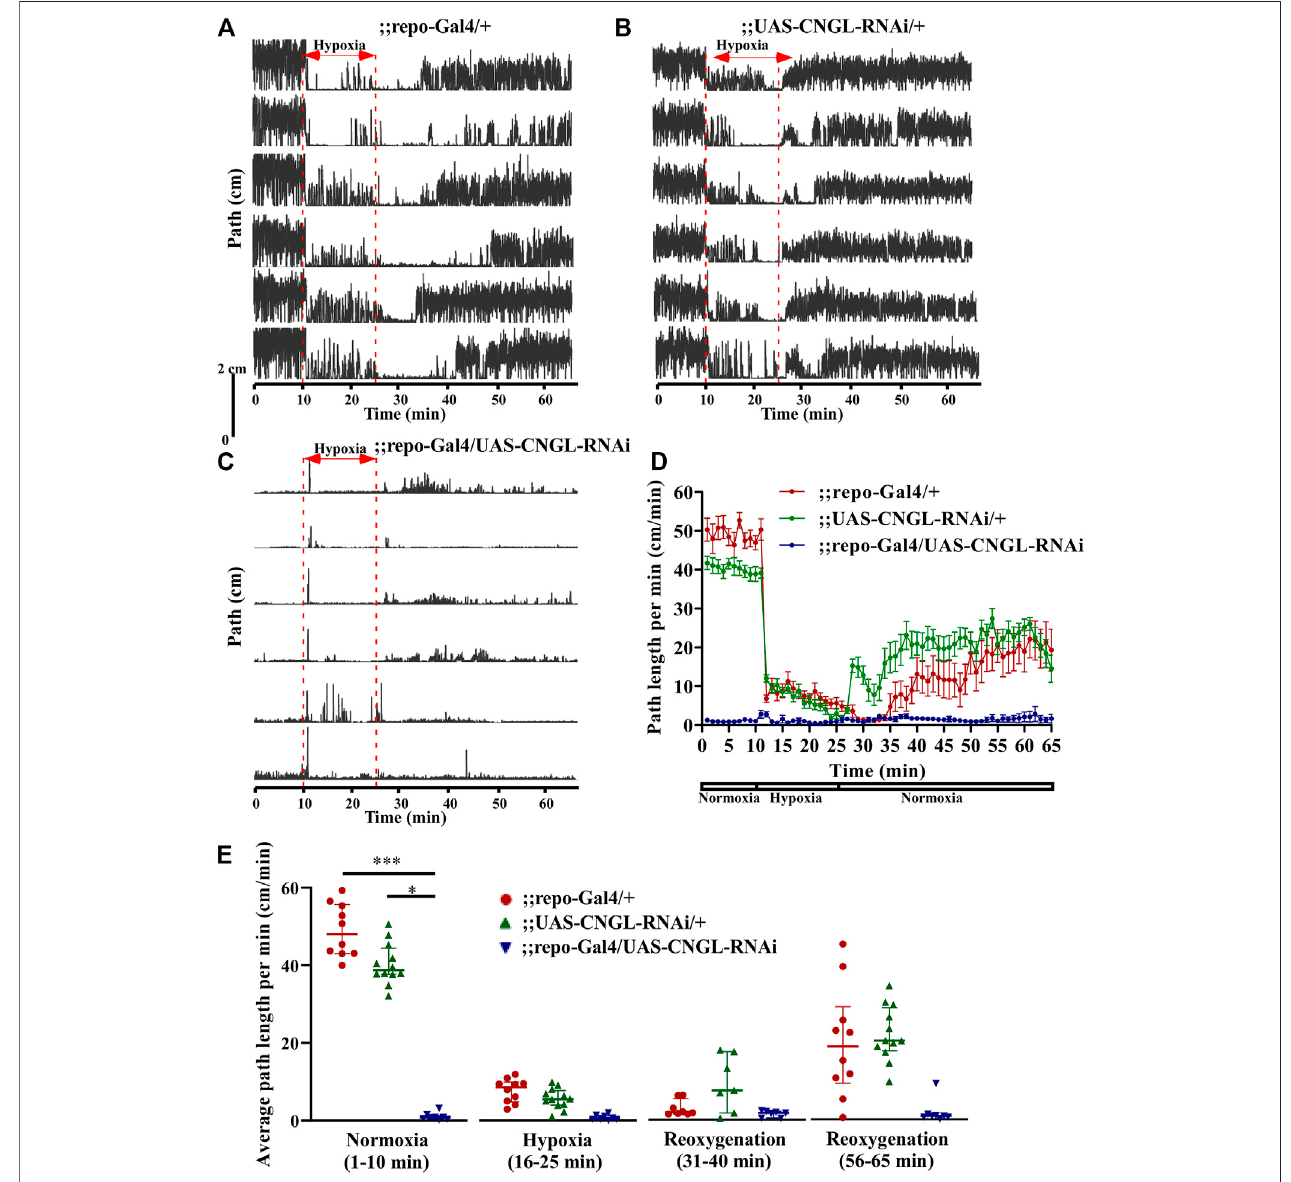
FIGURE 4 | Reduced locomotor activity under normoxia in fl ies with CNGL knockdown in glia. (A – C) Locomotor analysis for fl ies with pan-glial CNGL down- regulationandcontrol fl ieswithhypoxia. (D) Pathlengthperminuteofcontrol fl ies(;repo-Gal4/+;,redcirclesandredline, n =10,and;UAS-CNGL-RNAi/+,greencircles and green line, n = 12) and CNGL pan-glial knockdown fl ies (;repo-Gal4/UAS-CNGL-RNAi, blue circles and blue line, n = 8) during normoxia, hypoxia and recovery process. (E) Theaveragepath length perminuteundernormoxia (1 – 10 min), duringhypoxia(16 – 25 min),and during reoxygenation (31 – 40 min and56 – 65 min)of control fl ies and fl ies with CNGL knockdown in glia. Asterisks (* or ***) indicate p < 0.05 or 0.001, respectively, by Kruskal – Wallis test with Dunn ’ s multiple comparison.